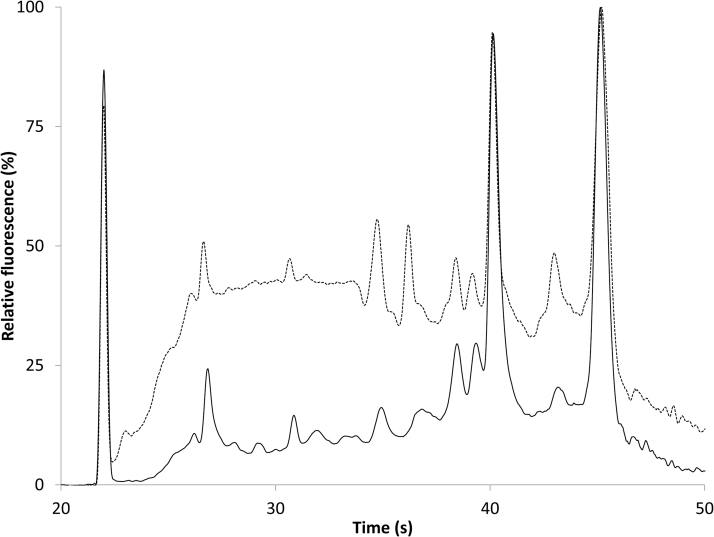
Electropherograms from seed coats, transformed to show the percentage of the maximum fluorescence for that RNA sample. Solid line, seed coat from 2-year-old seed (2014 harvest, RIN=6.9; also shown in Fig. 2D); dashed line, seed coat from 27-year-old seed (1989 harvest, RIN=4.7). Seed coats were extracted with the Qiagen RNeasy kit.